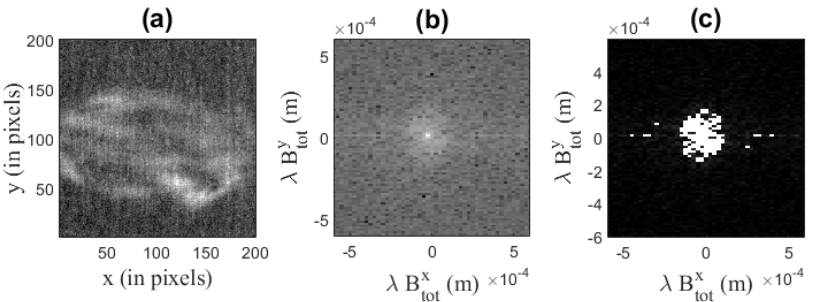
Figure 11. Section of the interferometric image of particle 3 (in white in Figure 7) that will be 2D Fourier-transformed ( a ), the log of its 2D Fourier transform ( b ), and its binarization ( c ). For particle 4 (encircled in cyan in Figure 7), the results are presented in a similar form in Figure 12. The dimensions of the particle can be estimated to be 140 × 150 μm .